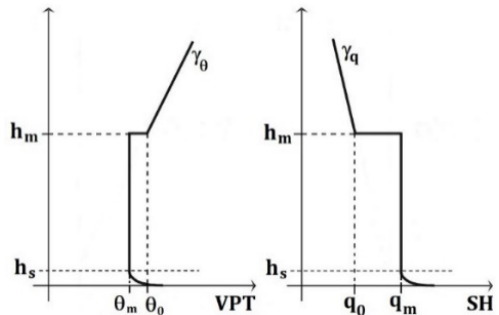
Figure 2. Idealized profiles of virtual potential temperature (VPT) and specific humidity (SH) from the standpoint of the slab model of the convective boundary layer (CBL).